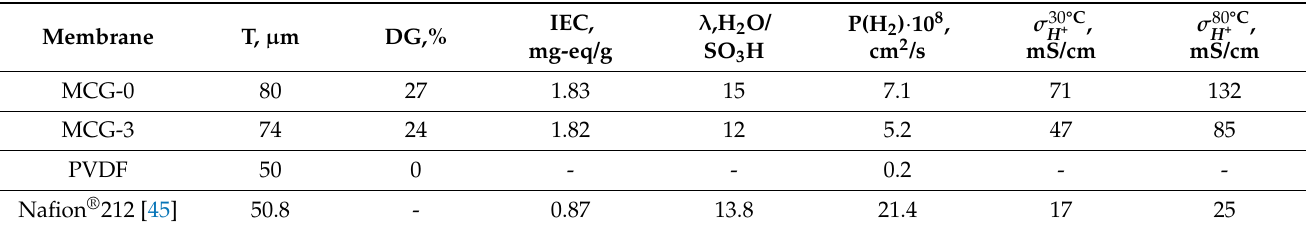
Table 1. Thickness (T), degree of grafting (DG), ion exchange capacity (IEC), hydration numbers ( λ ), hydrogen permeability (P(H 2 )), and conductivity ( σ ) of the membranes.